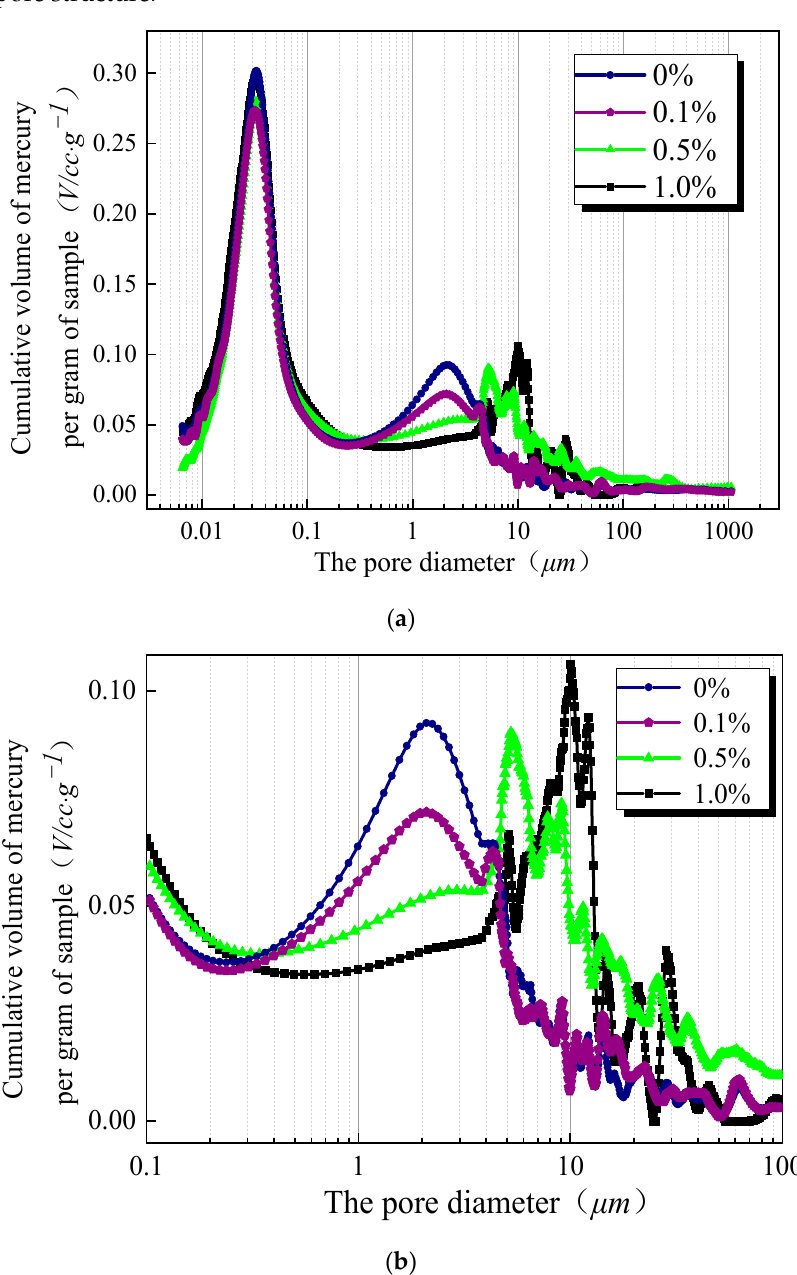
Figure 1. Pore distribution of Guilin red clay under the effect of different Pb 2 concentrations. ( b ) is an enlarged view of the 0.1–100 μ m segment in ( a ).